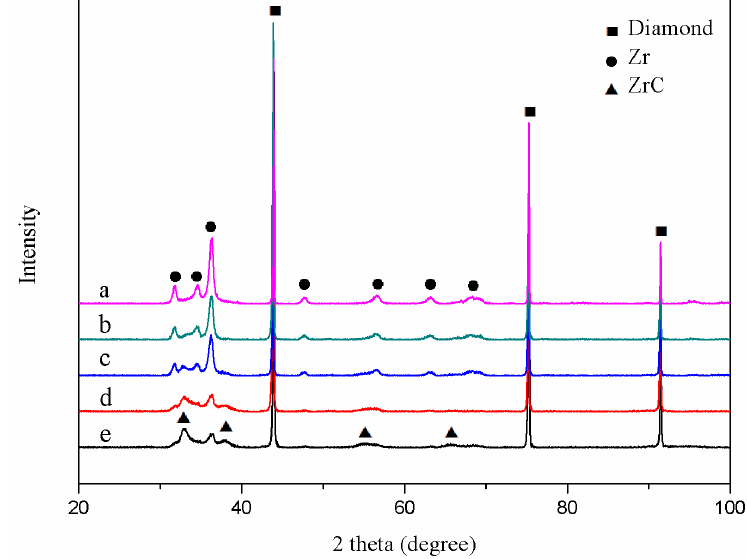
Figure 1. Micro-morphology of ( a , b ) uncoated and ( c , d ) ZrC/Zr-coated diamond particles.